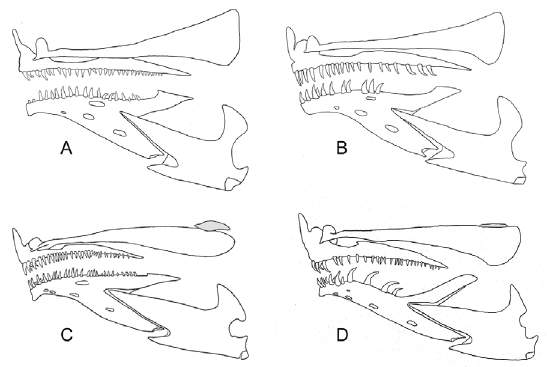
Figure 5. Jaws and dentition (supramaxilla shaded) in selected species of Opistognathus . A O. thionyi , CIUFES 2393, 53.5 mm SL, Fernando de Noronha Archipelago, Brazil B O. vicinus , NPM 5030, 47.4 mm SL, Brazil C O. lonchurus , ANSP 126637, 75.0 mm SL, Gulf of Mexico D O . aff. aurifrons , ANSP 188905, 63.8 mm SL, Table 4. Morphometric data for holotype and six paratypes of Opistognathus vicinus .